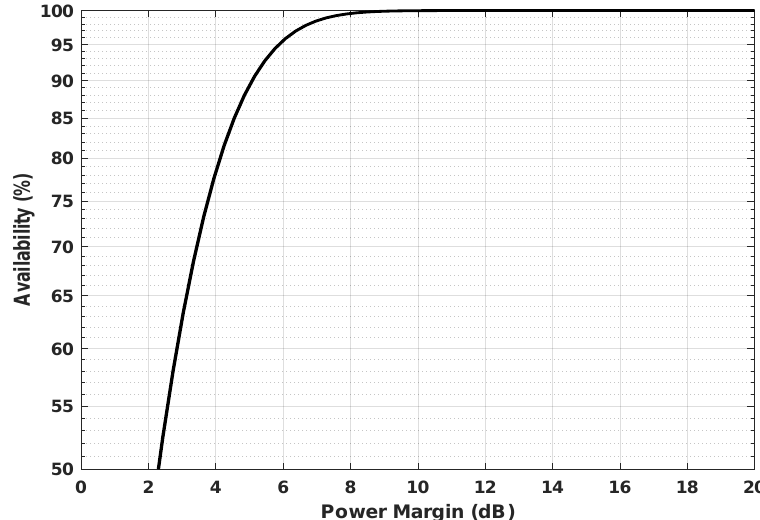
Figure 12. Proposed System Winter Availability.